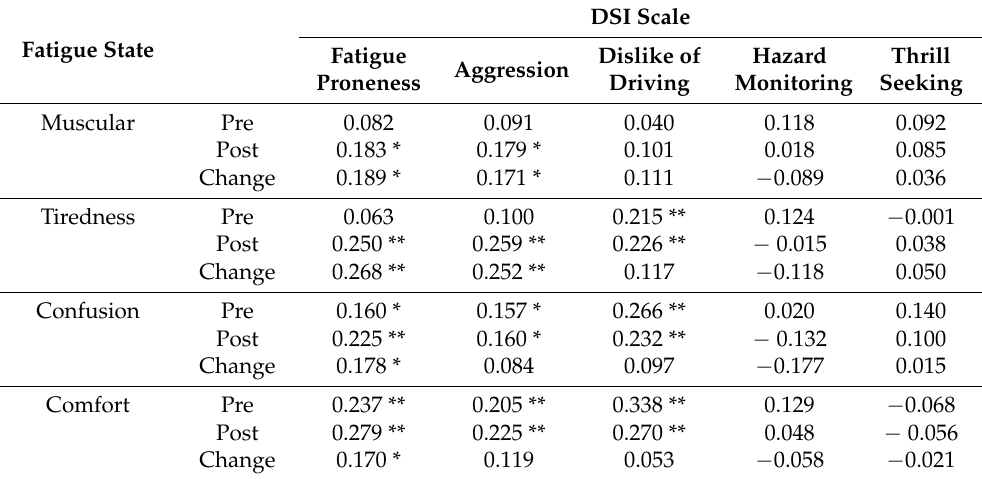
Table 3. Correlations between DSI scales and four fatigue state dimensions.